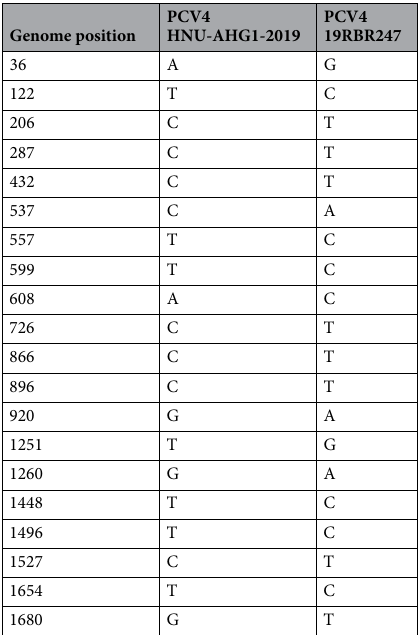
Table 3. Nucleotide sequence comparison between Thai PCV4 strain (19RBR247) and the prototype PCV4 strain